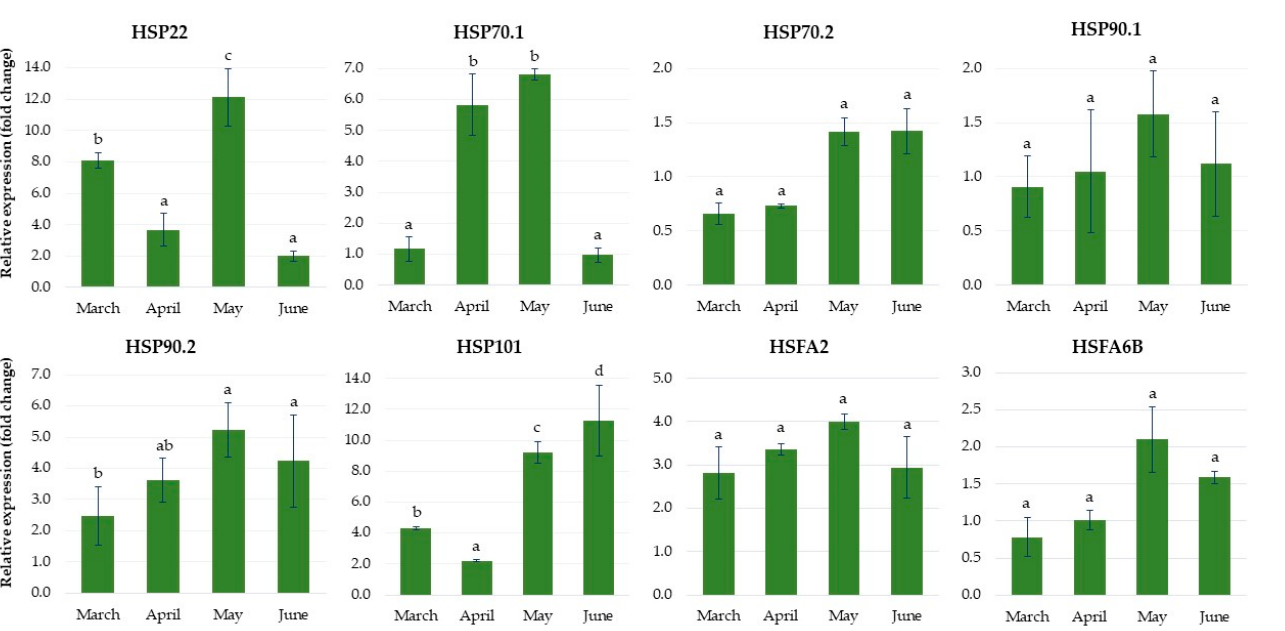
Figure 14. The relative expression of the genes involved in antioxidant metabolism in rhubarb ‘Raspberry’ plantlets during ex vitro growth in the greenhouse from early March to the end of June. According to Duncan’s test ( p = 0.05), means marked with the same letter do not differ significantly ( p = 0.05). Error bars represent standard deviation.